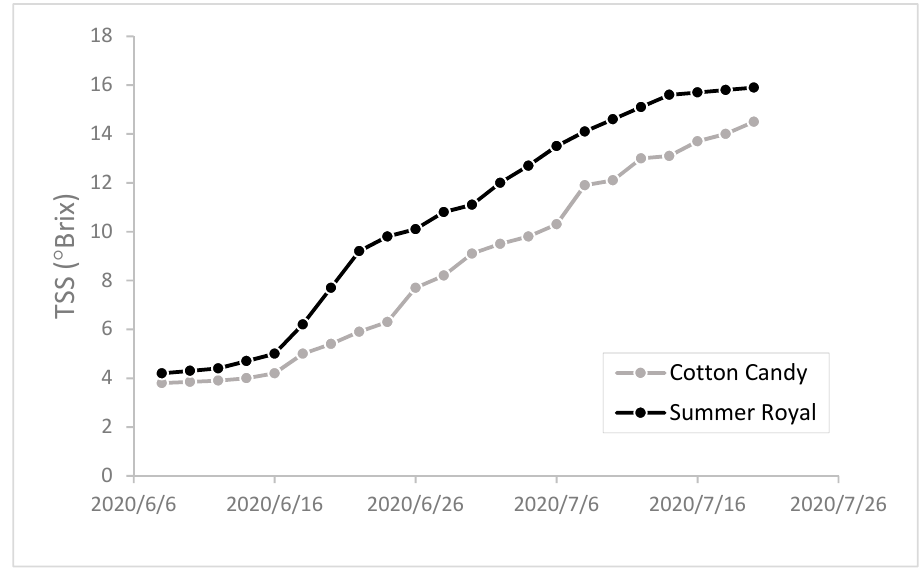
Figure 1. TSS (°Brix) evolution in Cotton Candy™ and Summer Royal in the season 2020.